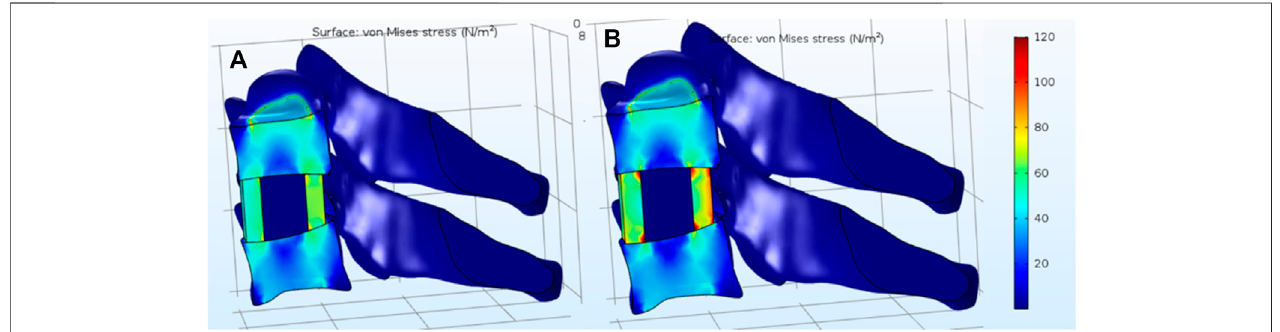
FIGURE 7 | Stress distribution under standing condition. (A) SF/nHAp composite cage. (B) Ti alloy cage.